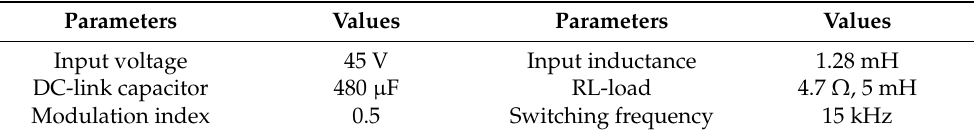
Table 1. Simulation parameters for five-phase SSI.